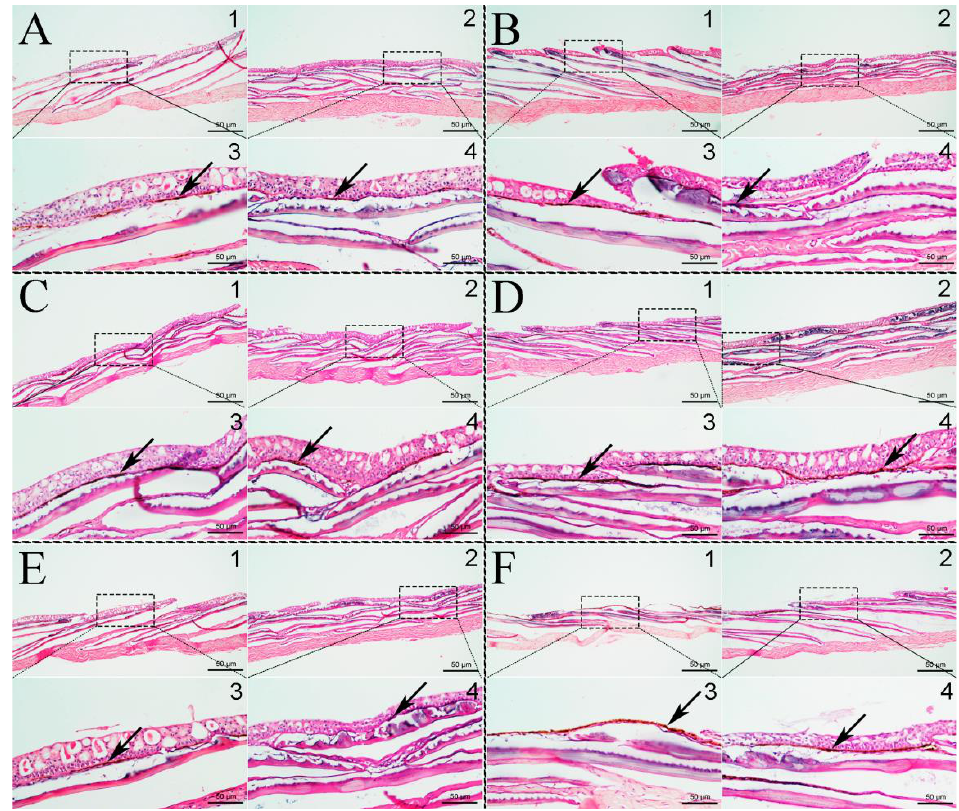
Figure 2. Slice microstructure observation of melanin zone in dorsal and ventral skin of P. leopardus . ( A ): Initial group; ( B ): Blue group; ( C ): Red group; ( D ): Black group; ( E ): White group; ( F ): Transparent group. Black arrows indicate melanin. In the subfigures, 1 is the dorsal skin and 2 is the ventral skin. 3 is the local amplification of 1, and 4 is the local amplification of 2. Table 3. Effects of background on the L*, a*, and b* values of the head and caudal peduncle skin. Head Skin Caudal Peduncle Skin